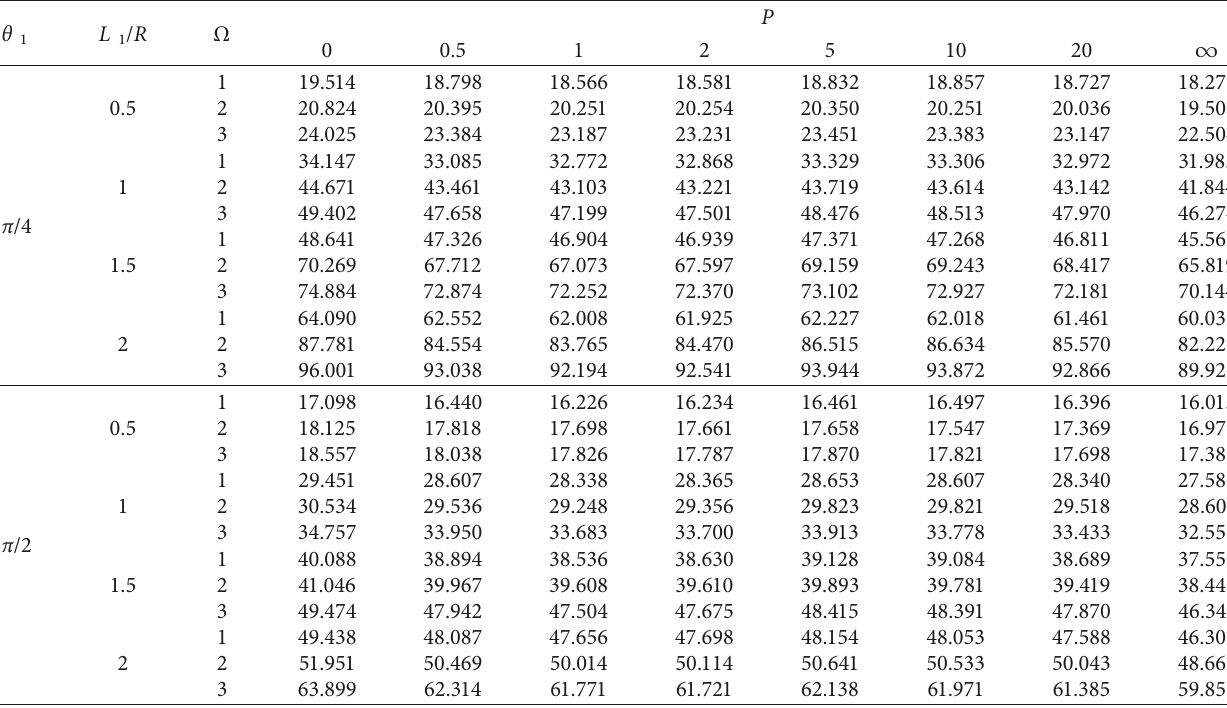
Table 7: Frequency parameters for FGM � 1/ b � 0) open conical shell with one circumferential bulkhead and CCCC boundary II ( a